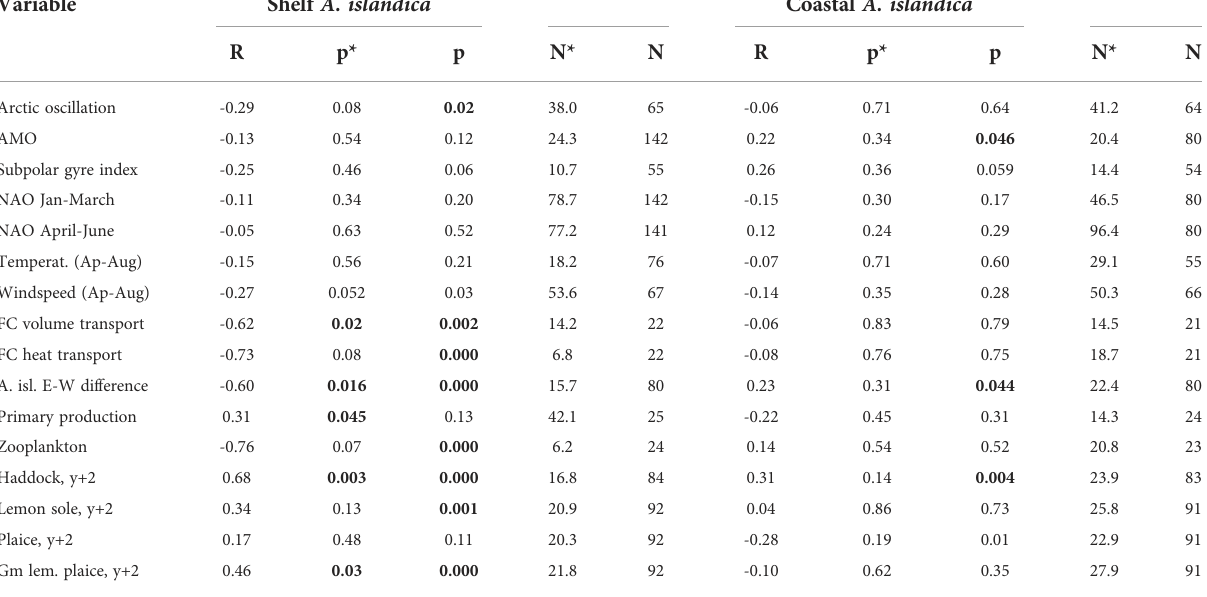
TABLE 2 Results from regression analyses between A. islandica growth indices from shelf sites (KES) or coastal sites (NVOH) and a variety of variables.